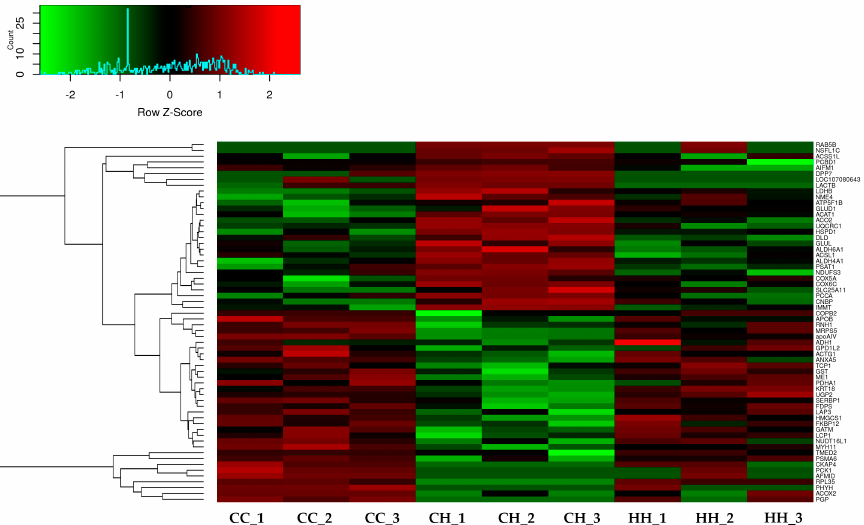
Figure 2. Effect of acute or early heat exposure on heatmap expression by differentially expressed proteins. CC: control group. CH: acute heat stress group. HH: early and acute heat exposure group.